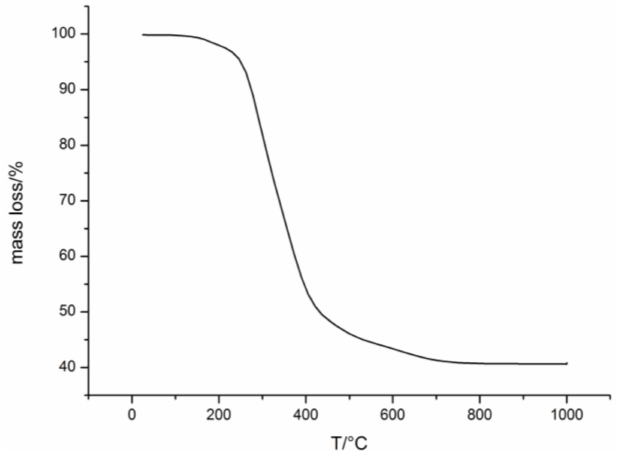
Figure 5. Photograph of a free-standing particle-based film processed through melt-shear organization.